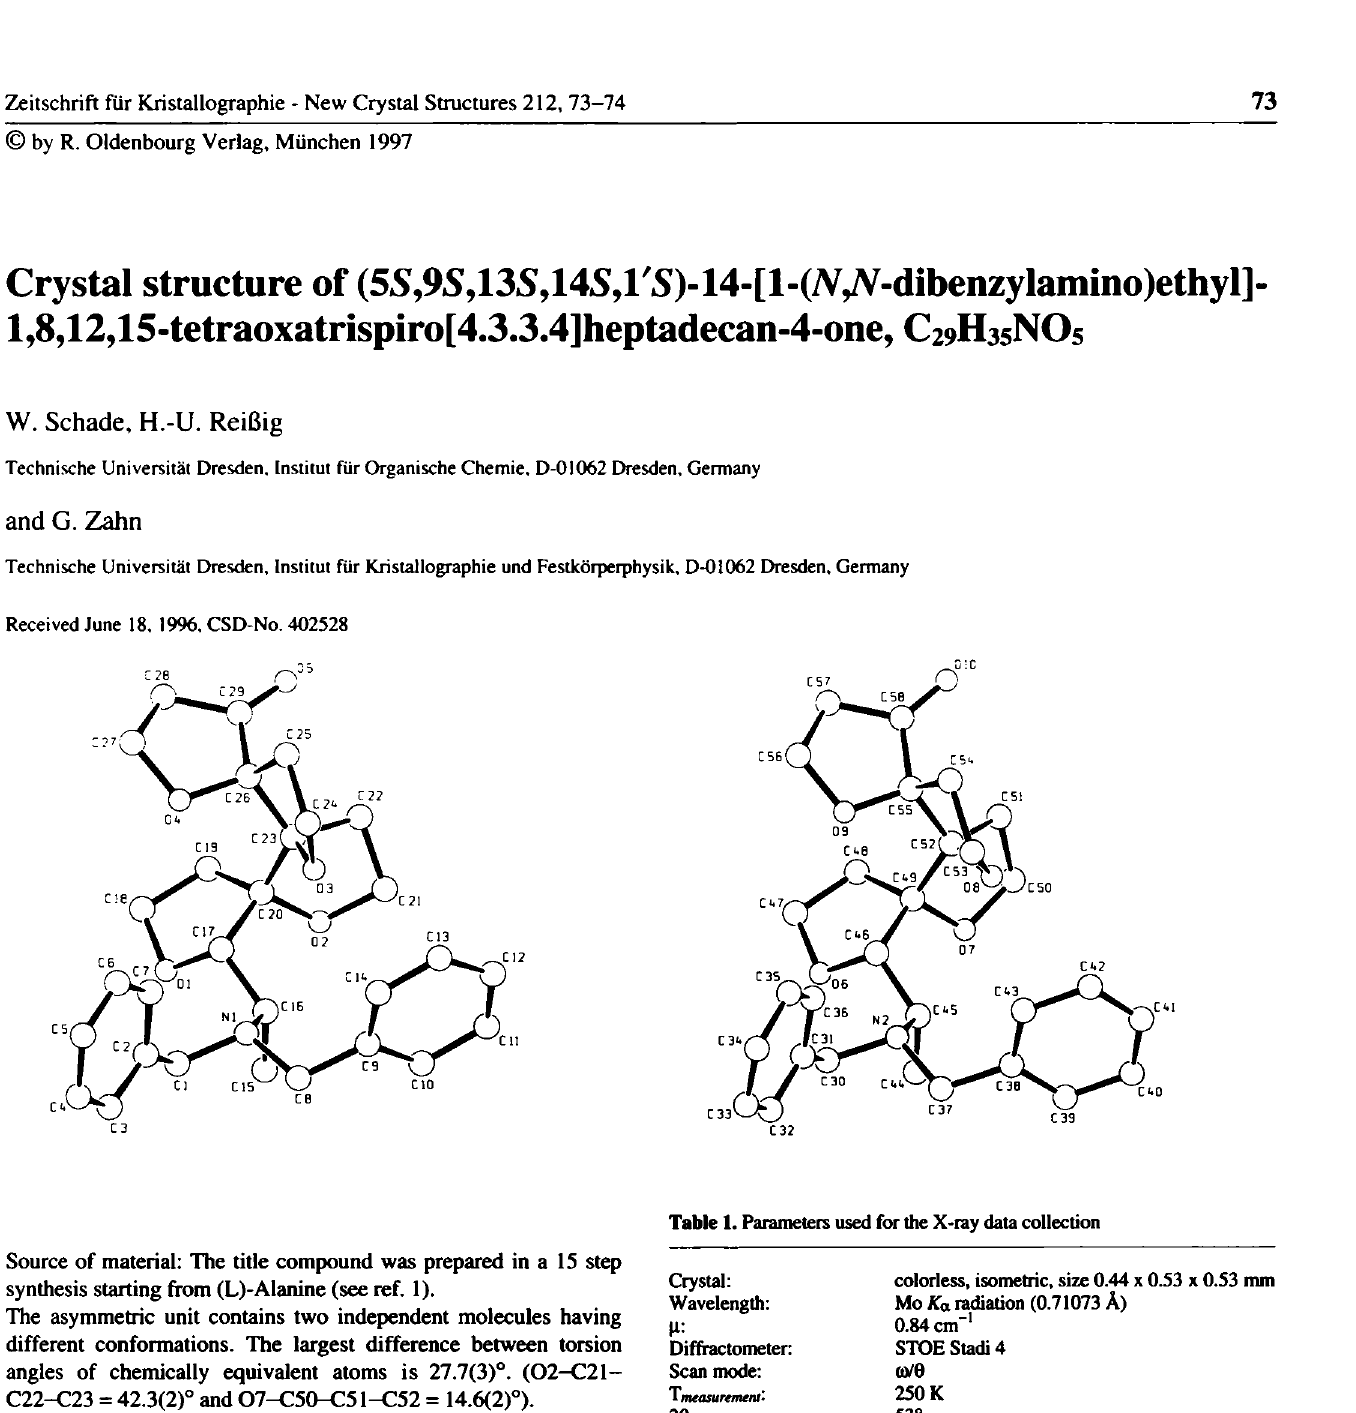
Table 1. Parameters used for the X-ray data collection